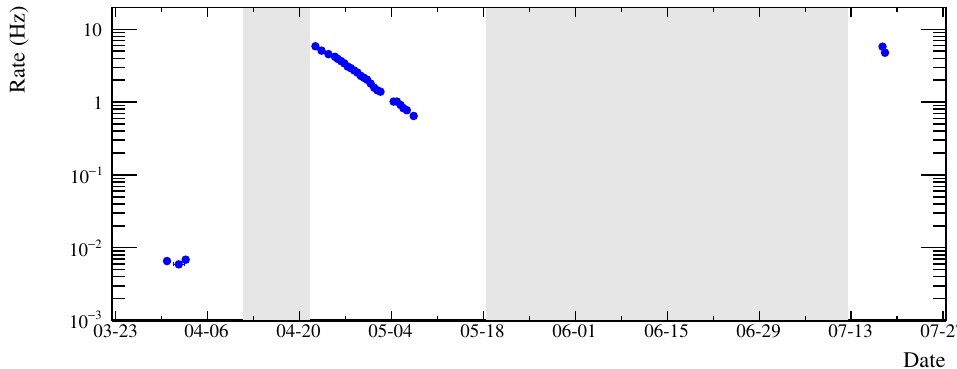
Figure 3 . Alpha production rate during run periods A1{A3. Grey areas indicate periods when the ambient temperature getter was